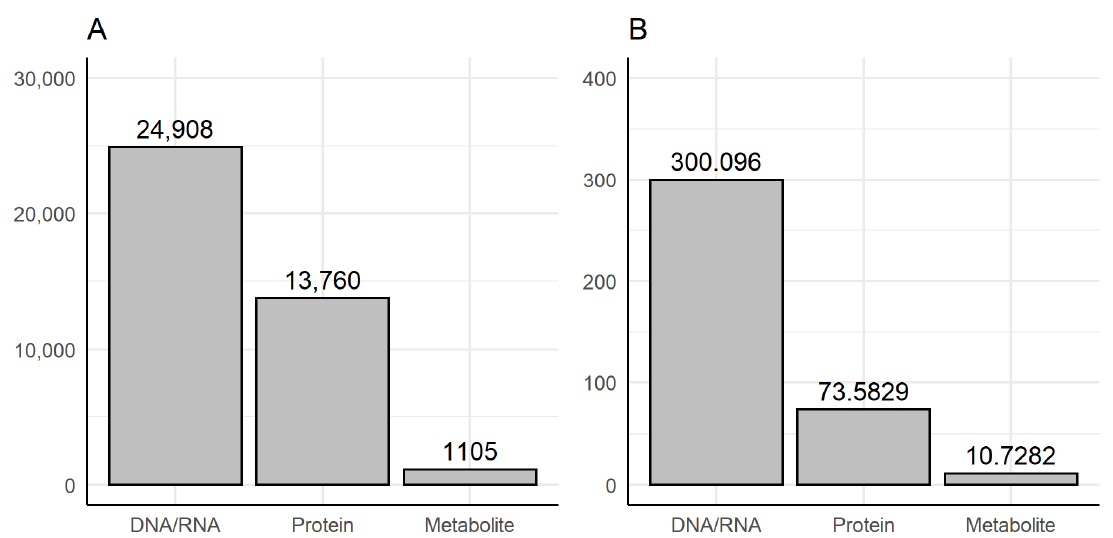
Figure 3. Results of the dictionary-based screening. ( A )—raw numbers of the text fragments in categories. ( B )—numbers adjusted by the dictionary’s size (raw number/number of terms in the corresponding category).